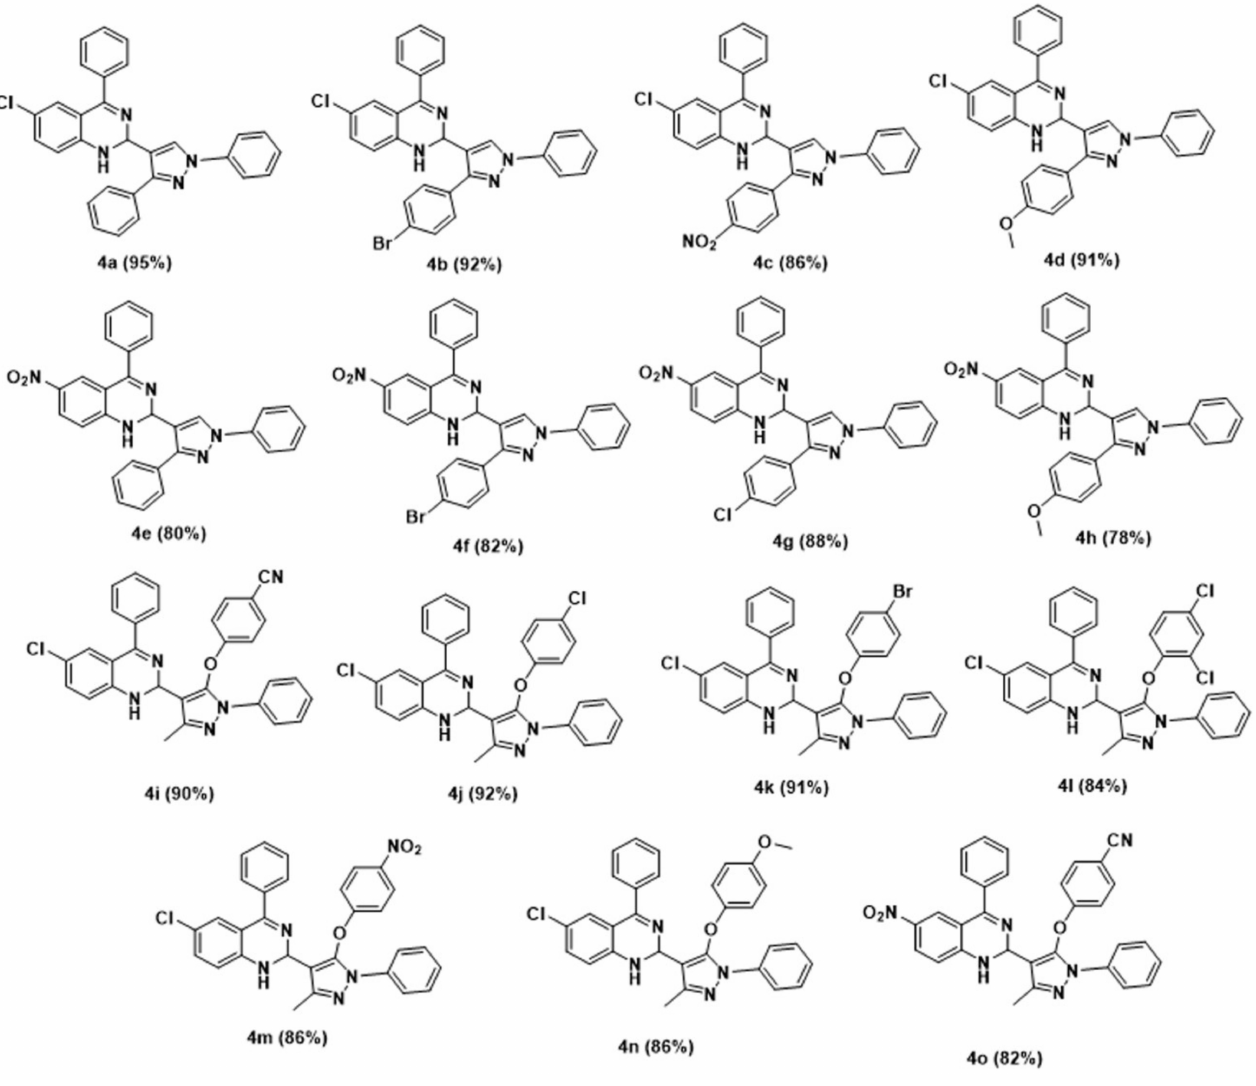
Figure 9. Diversity of the synthesized